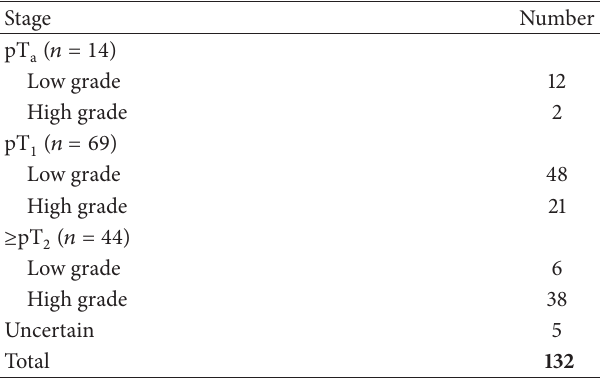
Table 3: Different pT stages of urothelial